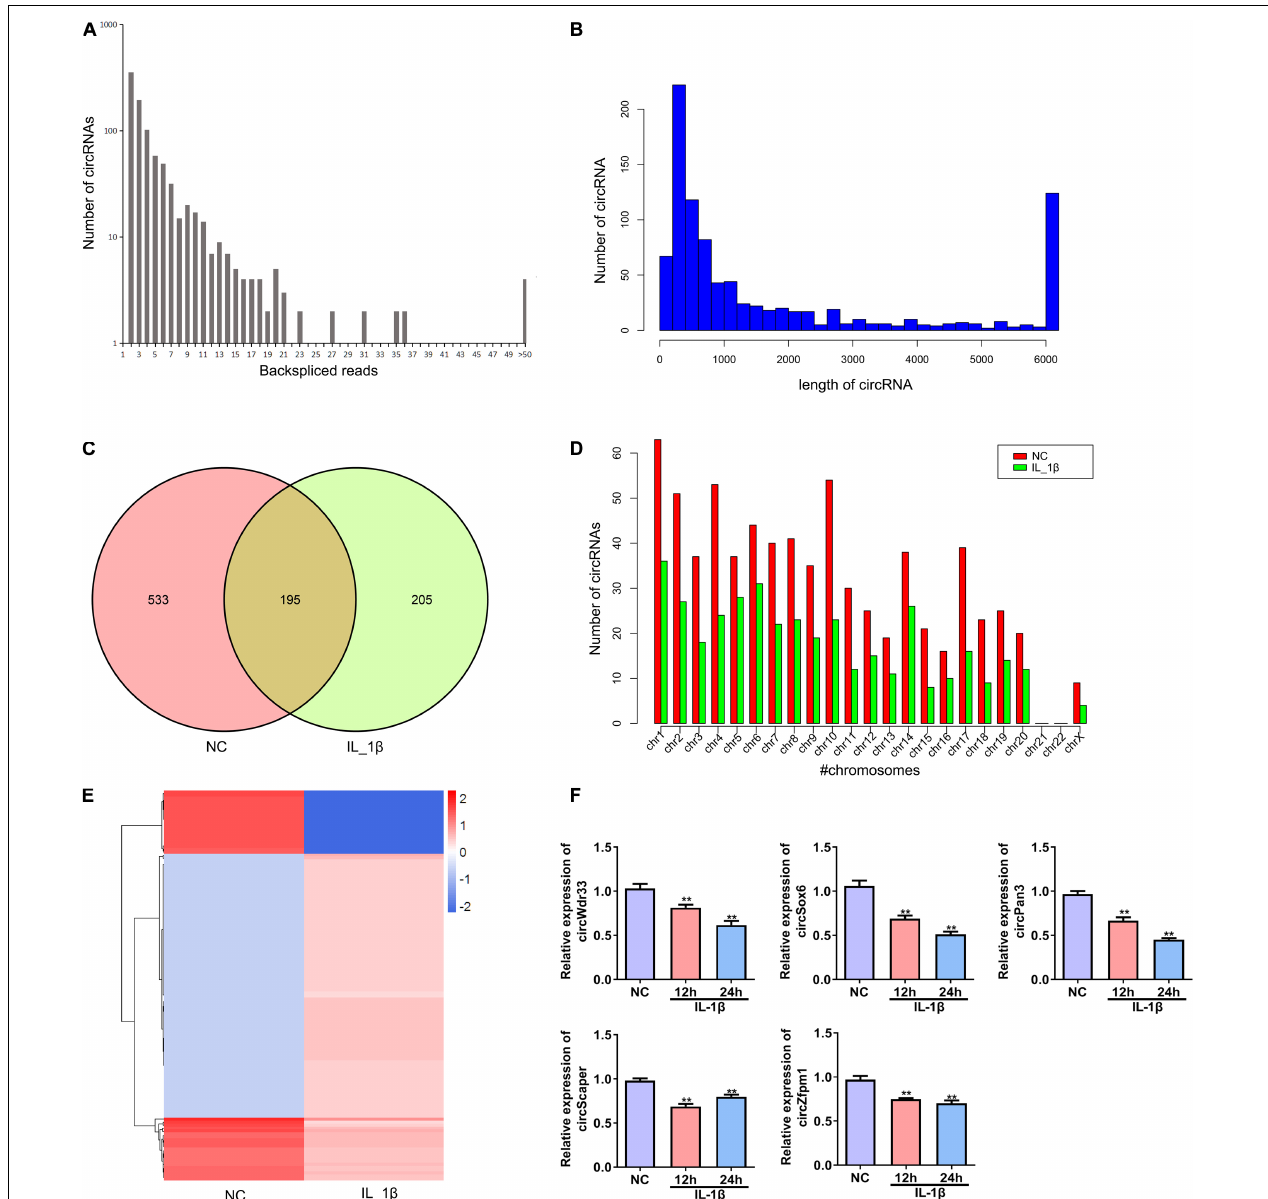
FIGURE 2 | Profile of differentially expressed circRNAs in rat chondrocytes stimulated with IL-1 β . (A) The number of back-spliced reads of the circRNAs identified in chondrocytes by deep sequencing. The number of back-spliced reads and circRNAs are indicated in the X and Y axis, respectively. (B) Length distribution of identified circRNAs. (C) Venn diagram showing the number of circRNAs identified in the NC and IL-1 β -induced chondrocytes. (D) Chromosomes distribution of the circRNAs. The circRNAs identified in the NC and IL-1 β -induced chondrocytes are indicated by red and green bars, respectively. (E) Hierarchical clustering of differentially expressed circRNAs. CircRNAs between two groups with a P -value < 0.05 and a Log 2 ratio ≥ 1 were considered differentially expressed. (F) Relative expression of five representative differentially expressed circRNAs in IL-1 β -induced rat chondrocytes and the corresponding NC cells. The expression of circWdr33, circSox6, circPan3, circScaper, and circZfpm1 in chondrocytes was determined by RT–qPCR. RT–qPCR, quantitative real-time polymerase chain reaction; NC, normal control; IL-1 β , interleukin-1 β ; ** P < 0.01 versus NC, n = 3.